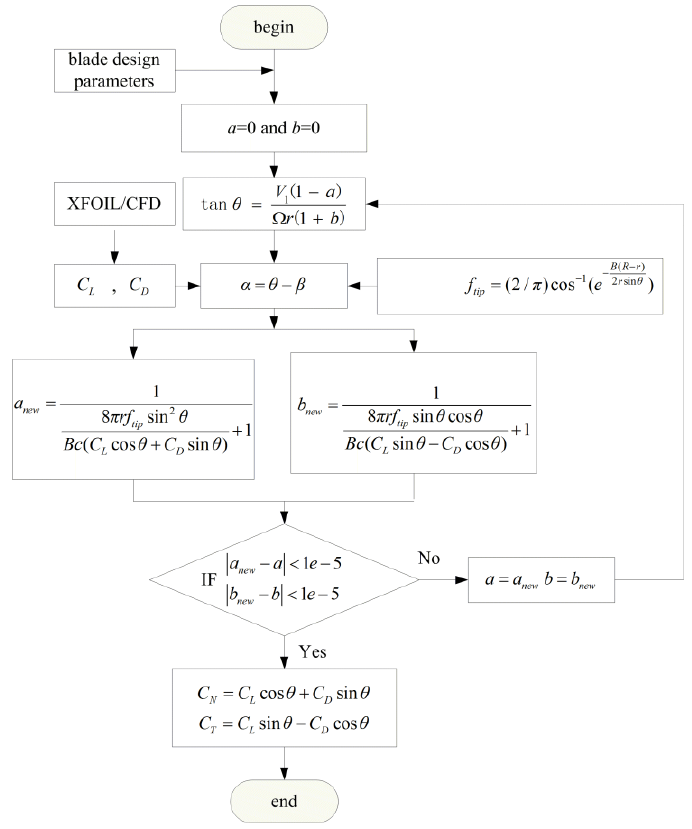
Figure 3. Flow chart of the code structure of the BEM.